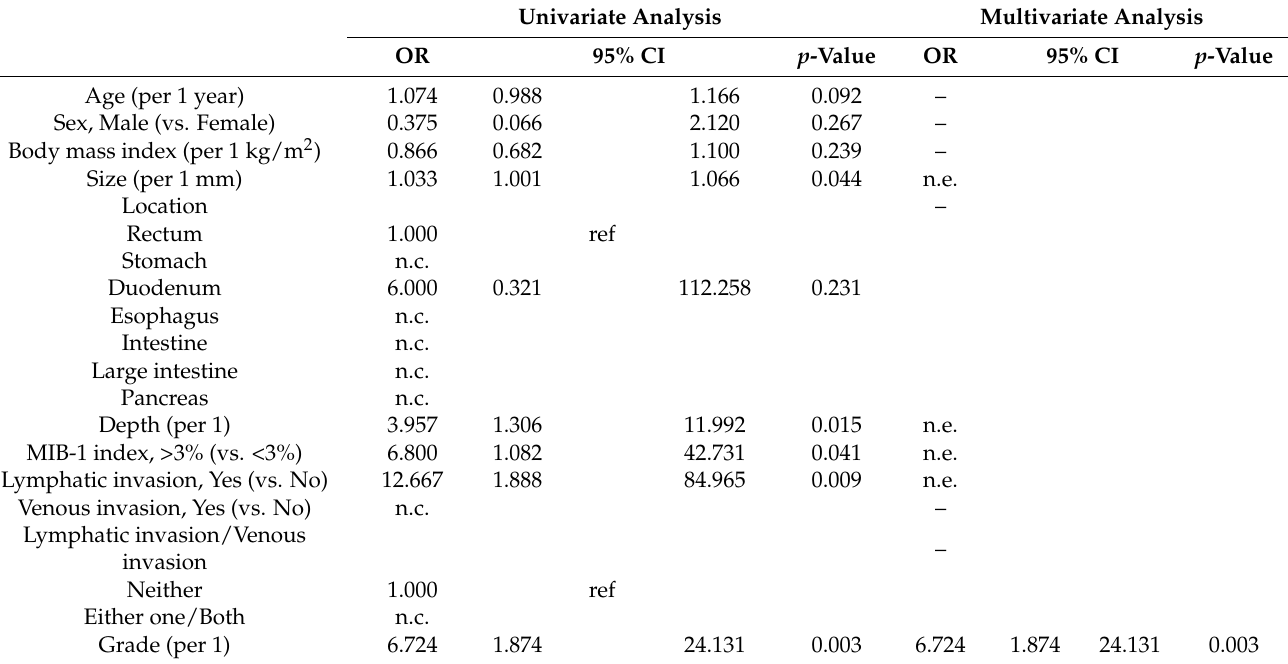
Table 2. Logistic regression analysis for lymph node metastases.